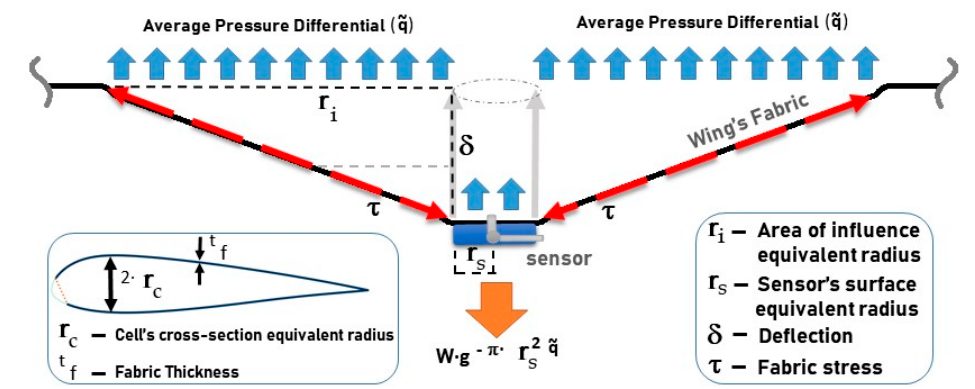
Figure 2. The simplified mechanism for sensor’s weight balance.